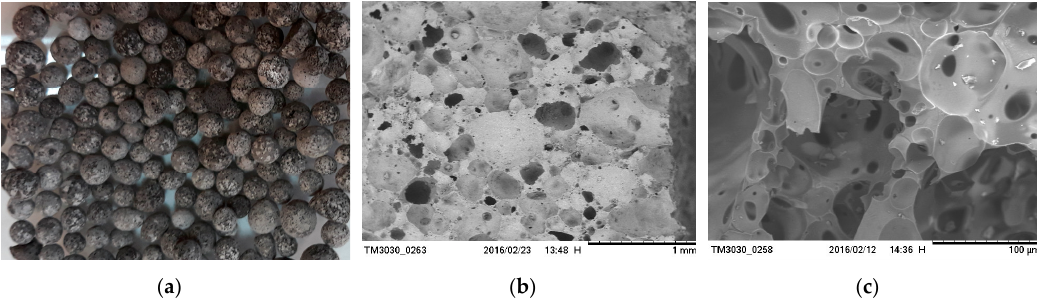
Figure 4. Granulated expanded glass aggregate GEGA ( a ); grains at 11.2 mm; ( b ) structure of GEGA, 200 × ; ( c ) structure of GEGA, 1000 × . Table 2. Chemical composition of the aggregate.